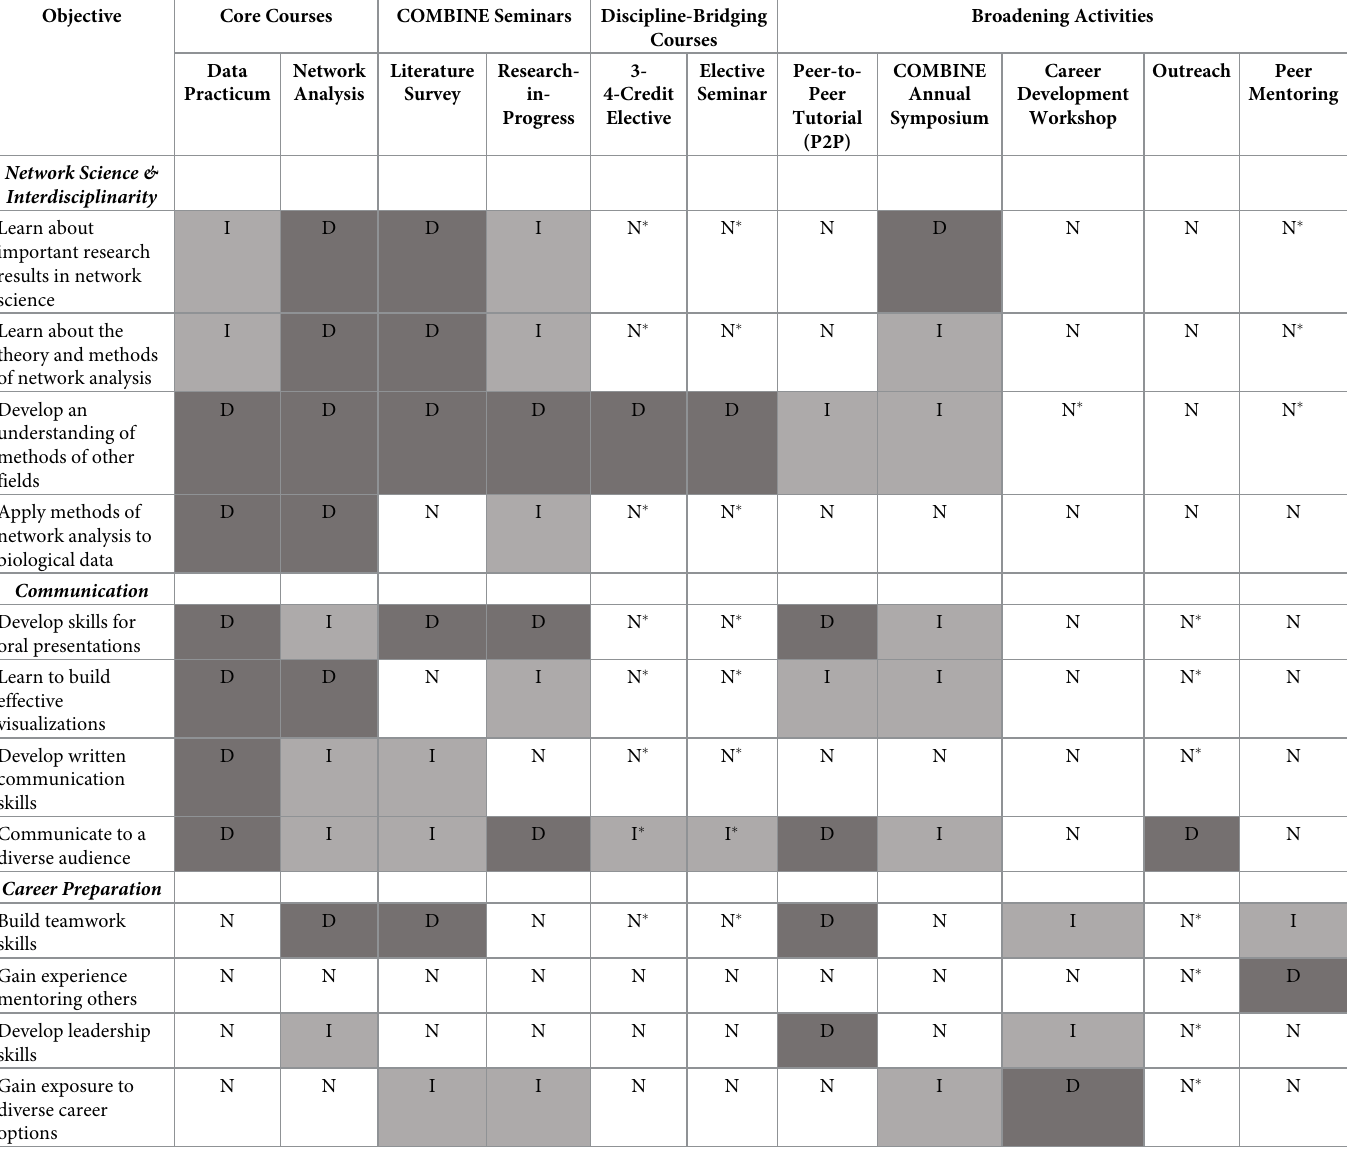
Table 3. Planned alignment between COMBINE objectives and components determined by the leadership